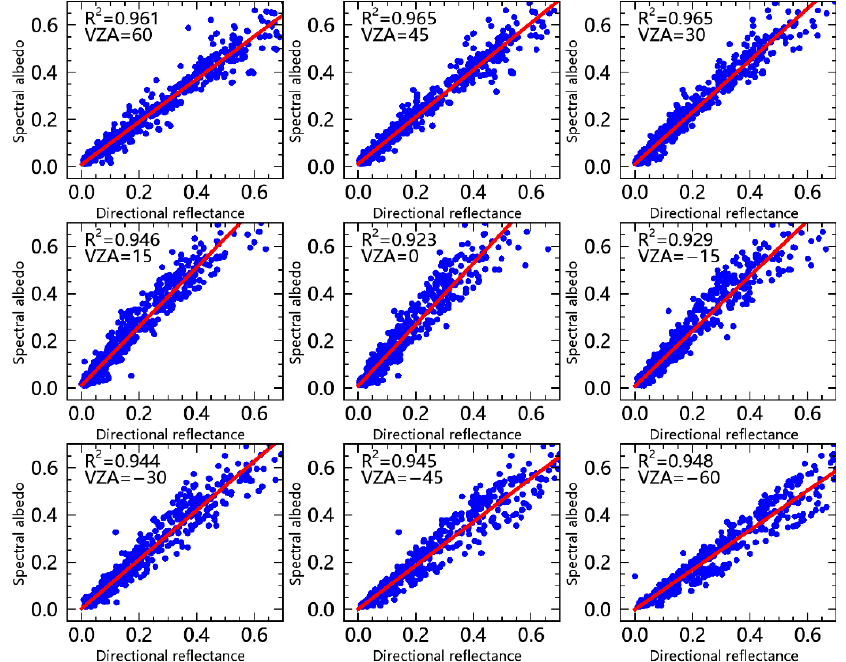
Figure 5. Relationships between directional reflectance and spectral albedo with different view zenith angles.